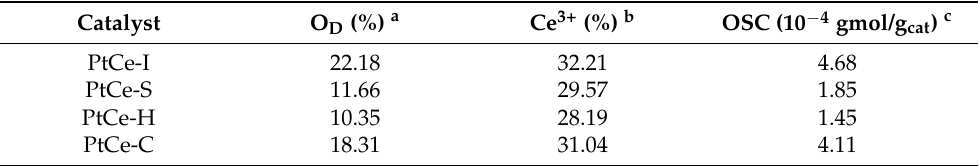
Table 2. Oxygen-storage capacity-related values of CeO 2 -supported Pt catalysts prepared by various synthesis